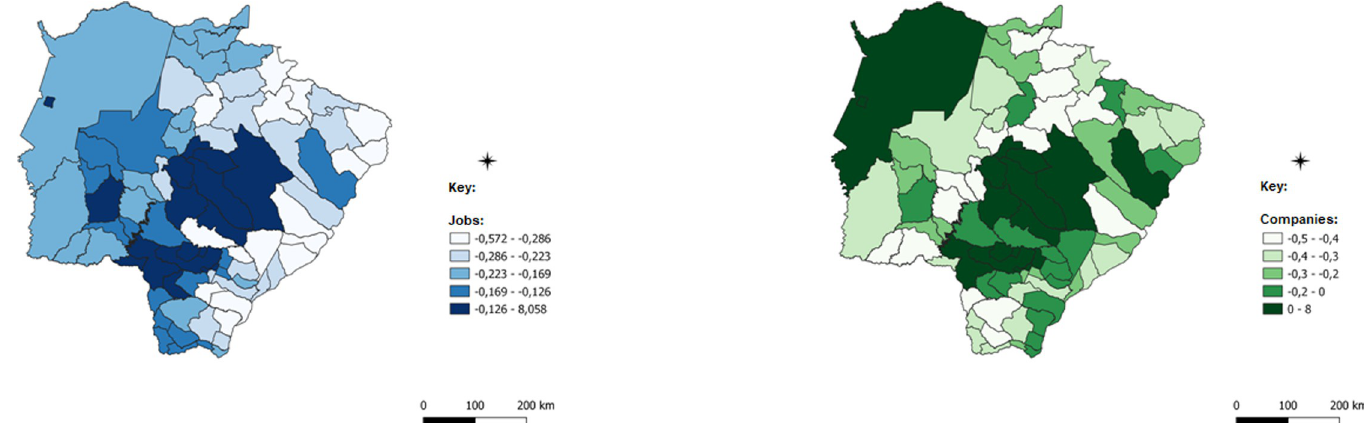
Fig 9. Spatially weighted Composite Concentration Index of Services. Caption credit: Elaborated from secondary data extracted from [26].